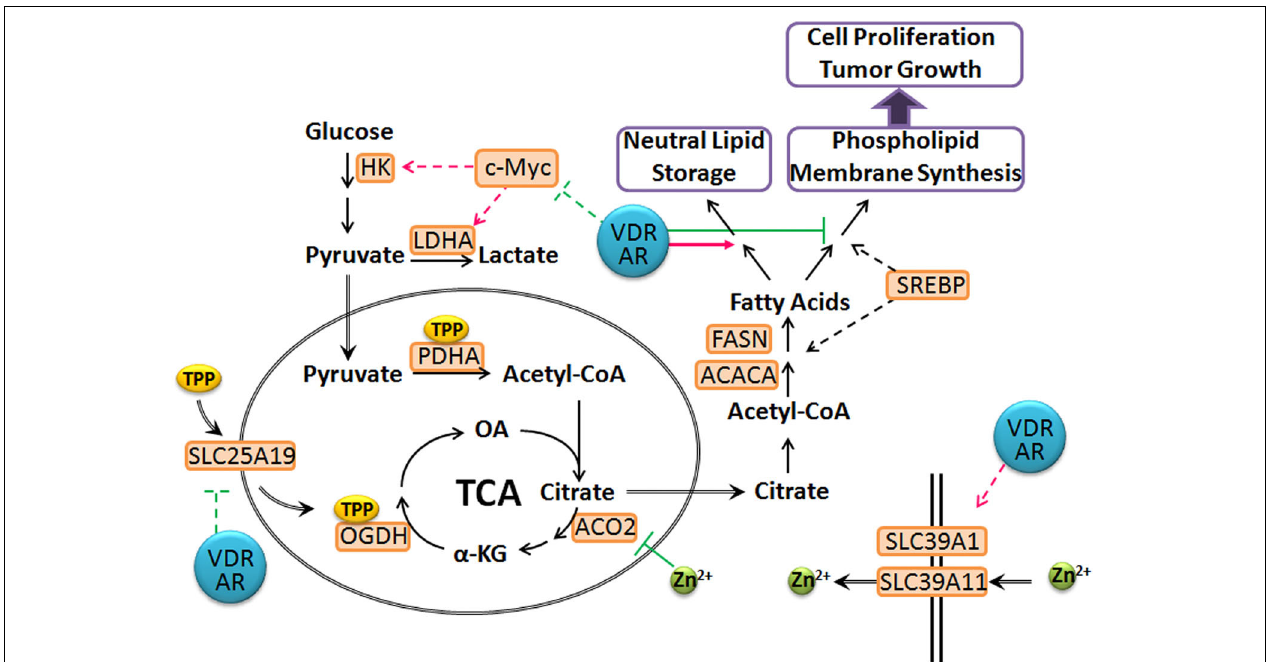
FIGURE 3 | Proposed model of T- and 1,25(OH) 2 D 3 -mediated prostate cancer metabolism. The VDR and AR axes modulate the expression of SLC25A19 and SLC39A11, leading to elevated intracellular zinc levels and deplete mitochondrial TPP pool, resulting in a truncated TCA cycle. Citrate is shunted into lipid synthesis and storage instead of phospholipid and